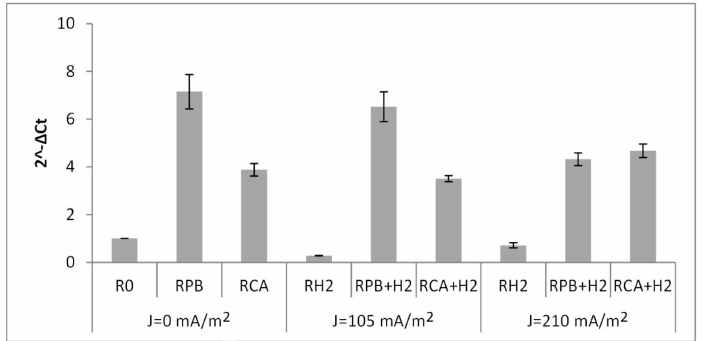
Figure 5. Relative abundance of denitrifying bacteria in the experimental reactors: R 0 —control reactor, without the electric current flow and without the external carbon source; R PB —reactor without the electric current flow and with the potassium bicarbonate dosage; R CA —reactor without the electric current flow and with the acetic acid dosage; R H2 —reactor with the electric current flow and without the external carbon source; R PB+H2 —reactor with the electric current flow and with the potassium bicarbonate dosage; R CA+H2 —reactor with the electric current flow and with the acetic acid dosage. In the R CA reactor, the efficiency of denitrification was 15.94( ± 1.53)% (Figure 3). The